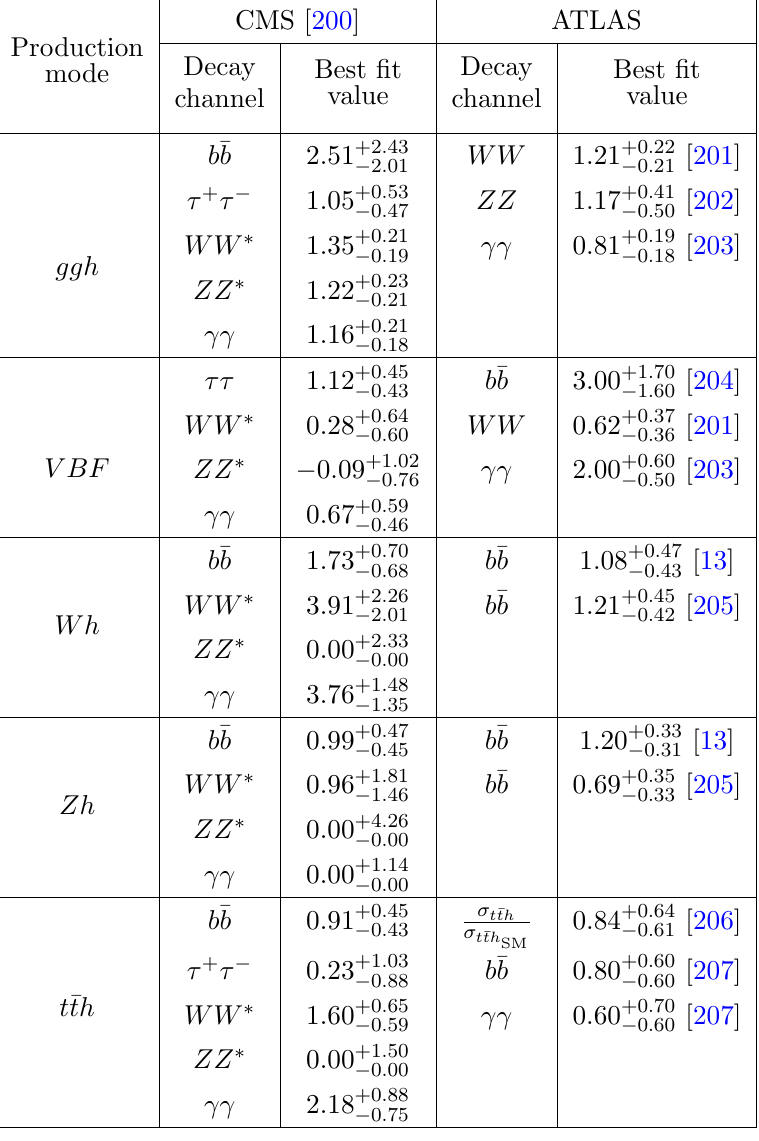
Table 18 . Best-(cid:12)t value of signal strength variables, along with the associated errors, derived by ATLAS and CMS using LHC Run-II data, which have been imposed on the parameter space region. and Higgs signal strength constraints in order to obtain the allowed parameter space region relevant for studying the current and future reach of direct heavy Higgs searches on the MSSM parameter